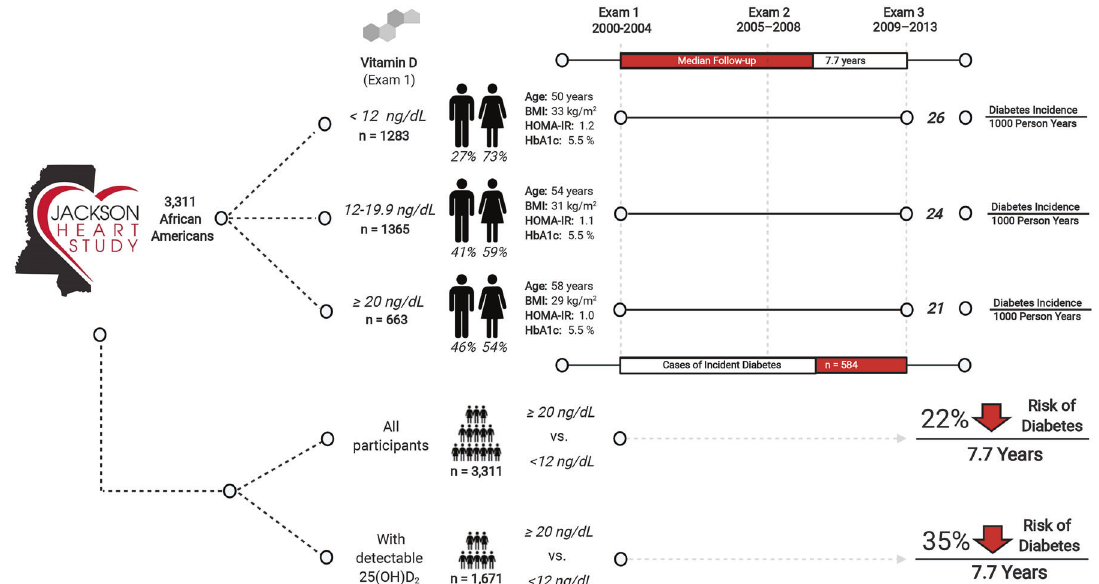
Fig. 1 The association of serum vitamin D with incident diabetes in an African American population. The fi gure presents the baseline characteristics by 25(OH) vitamin-D categories and shows the association of 25(OH)D with incident diabetes by 25(OH)D2 and 25(OH) D3